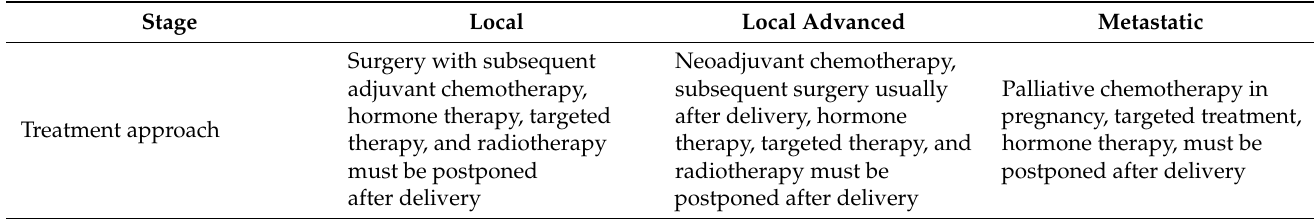
Table 2. Tailoring treatment according to the stage of breast